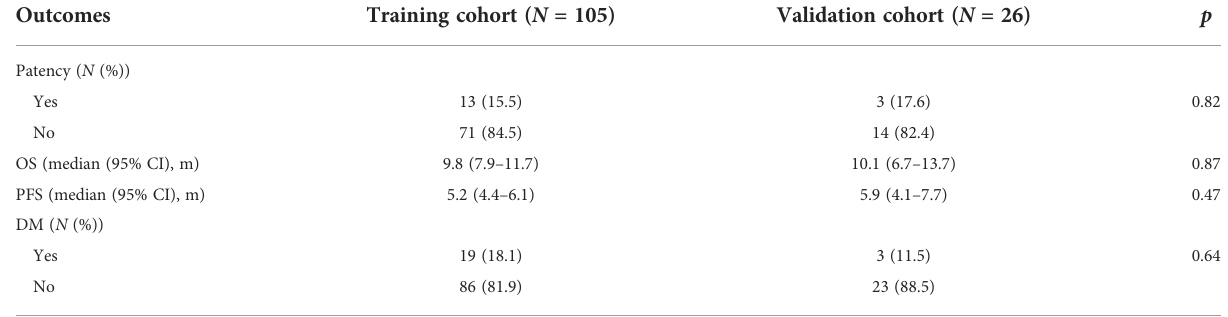
TABLE 6 Treatment outcomes of the training and validation cohorts.